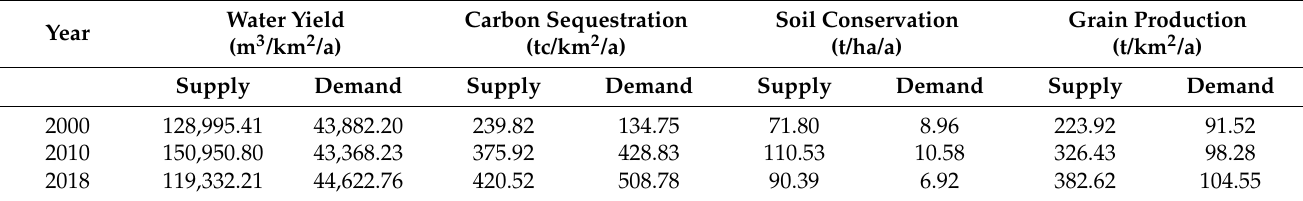
Table 2. Ecosystem services supply and demand in the Yellow River Basin in 2000, 2010, and